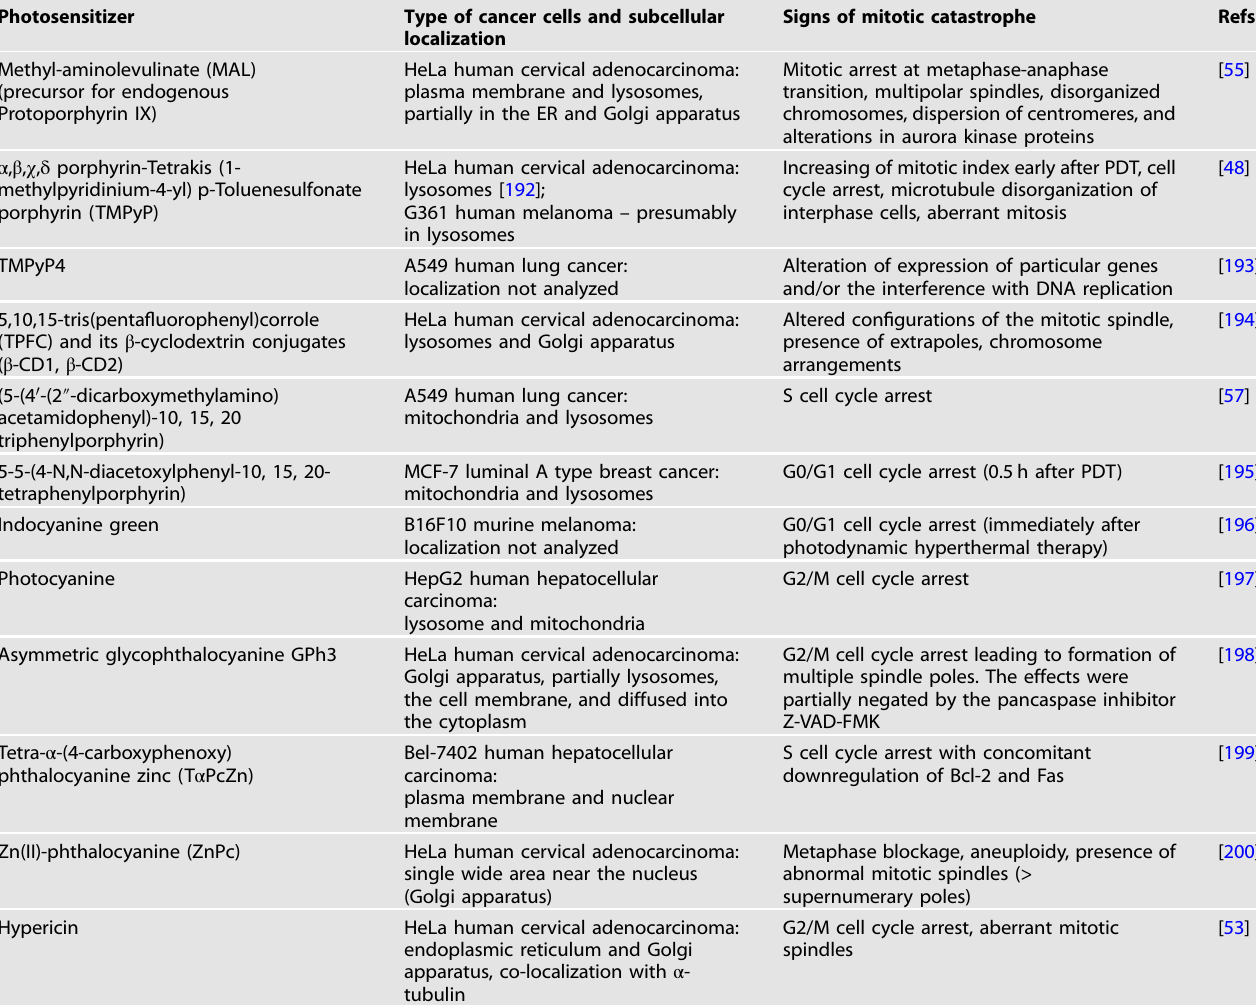
Table 1. PDT based on second generation photosensitizers can induce mitotic catastrophe in cancer cells.